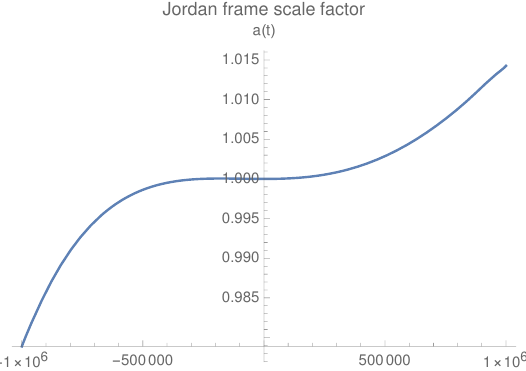
Figure 19. Time evolution of the scale factor in the Jordan frame in radiation background in exponential gravity found with the conditions H ( 0 ) = 0, ˙ H ( 0 ) = 10 − 14 , ¨ H ( 0 ) = 10 − 19